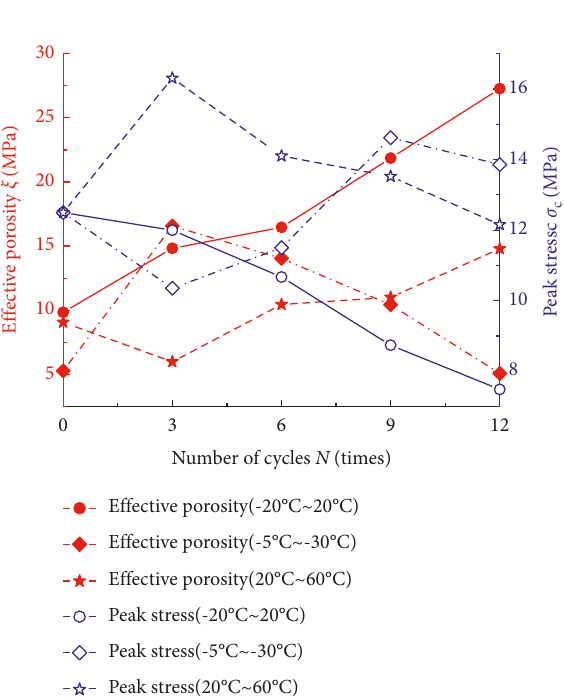
Figure 11: Peak stress and effective porosity after different number of